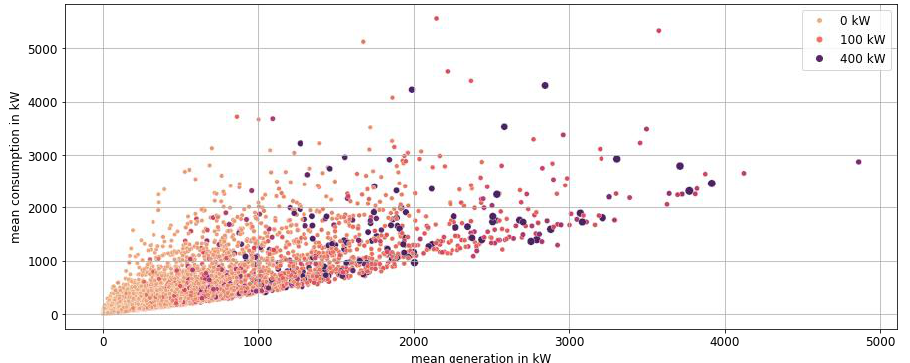
Figure A3. MAE of the trained ML model (supply) depending on mean generation and consumption within each municipality in the test set.